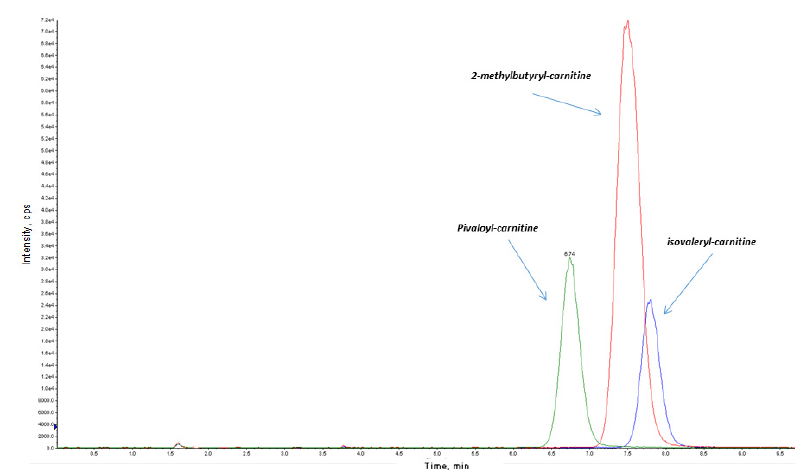
Figure 3. The 2-TT to reduce the false positive rate in expanded newborn screening for isovaleric acidemia (IVA). The contributions from different isobaric molecules can be separated by chromatography coupled with MS-MS as described in Poggiali et al. [26]. Interference causing false abnormal C5-acylcarnitine levels can be observed for pivalic acid supplementation or for 2-methylbutyrylglycinuria, a benign metabolic condition.